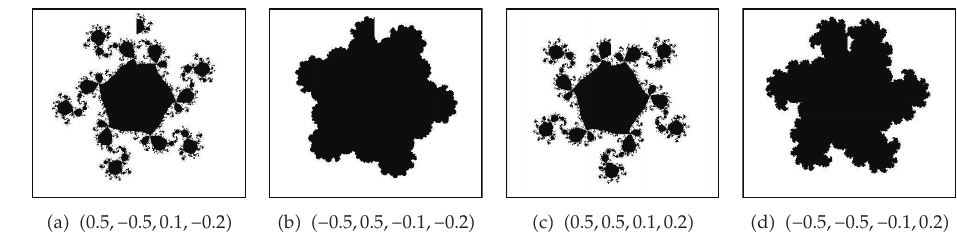
Figure 10: The generalized J sets perturbed by additive noise with di ff erent parameters (cid:3) a,b,m 1 ,m 2 (cid:4) when α (cid:6) 5 . 5, θ ∈ (cid:7) − π/ 2 , 3 π/ 2 (cid:4) .